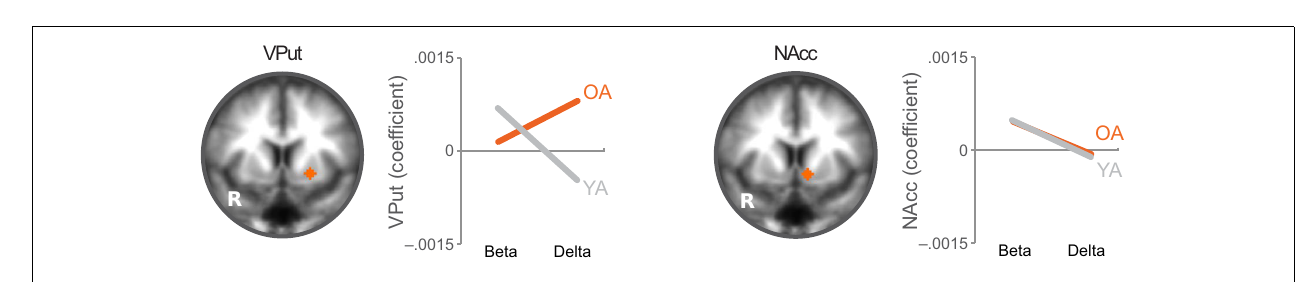
the two groups did not differ for either δ or β in the nucleus accumbens. Regions of interest were adjusted within subjects to only extract coefficients from gray matter. Anatomical underlay is an average of all subjects’ spatially normalized structural